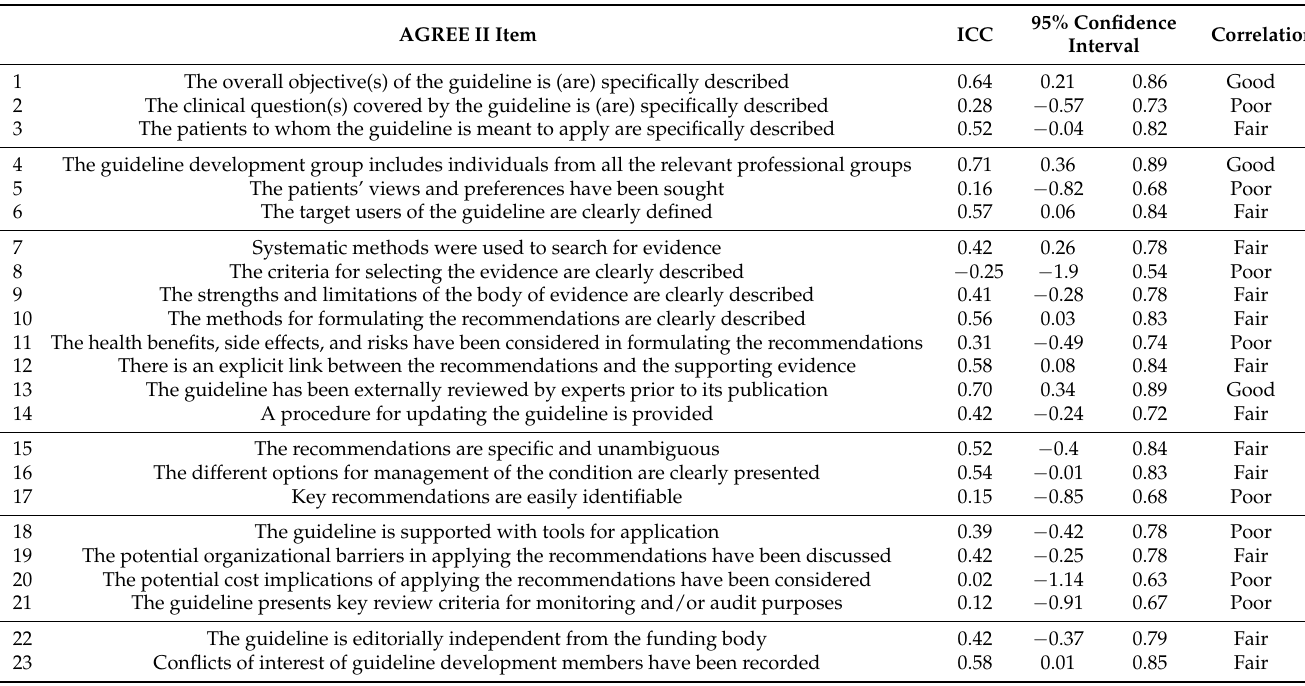
Figure 2. Box and whisker plot showing the median item score for all ASGs combined and range overlain with the median item scores for each individual ASG. Each ASG item score is represented by a color (green for median scores ≥ 5; orange for 4–5 and red for <4). See Table 3 for the description of each AGREE II item. Table 3. Intraclass correlation coefficients, 95% confidence intervals and interpretation for each AGREE II